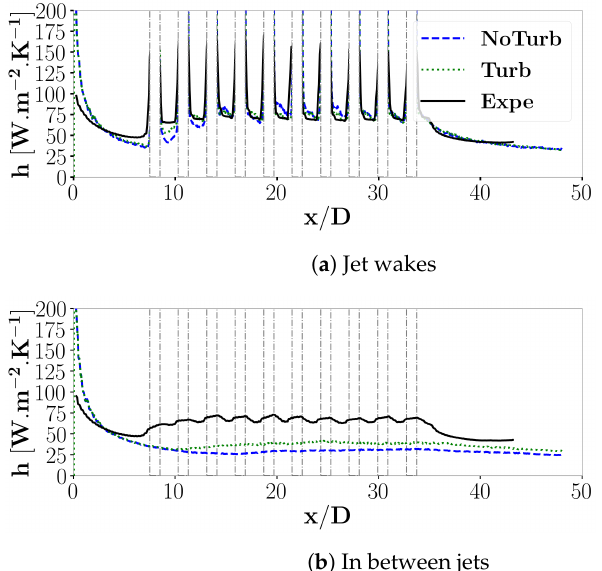
Figure 16. Time-averaged (over 5 periods) wall heat transfer coefficient h along different axes. Lab